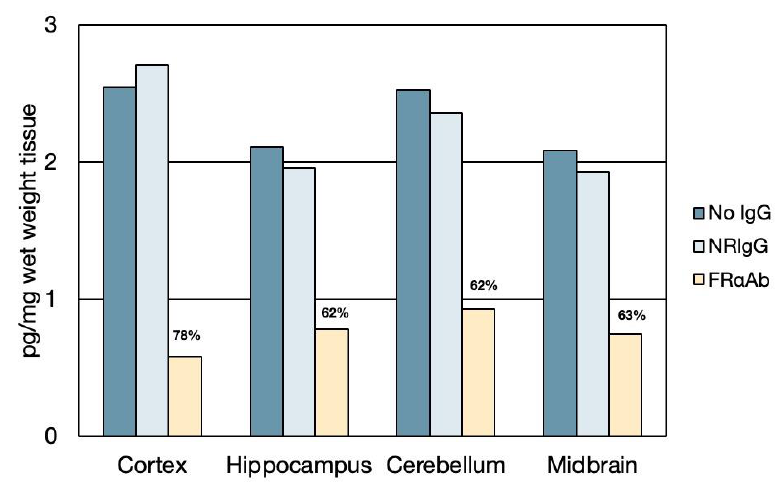
Figure 5. Effect of FR α Ab on brain uptake of 3 H-PGA. While NRIgG had no effect on 3 H-PGA uptake, a decrease of more than 60% was seen in all regions of the brain of the FR α Ab-injected animal (a single animal was used for each profile).